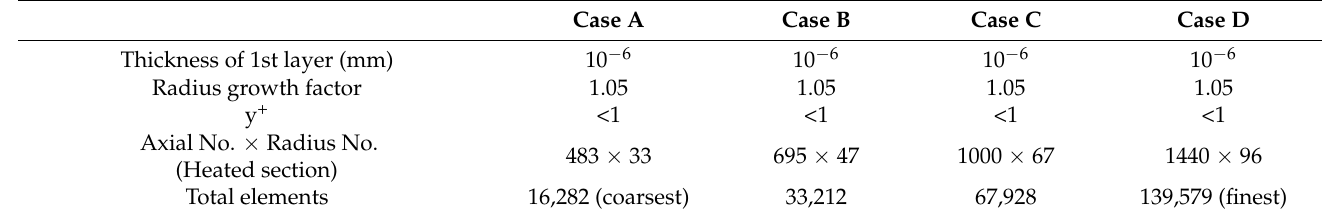
Table 2. Detailed information of the mesh generation for independence analysis.